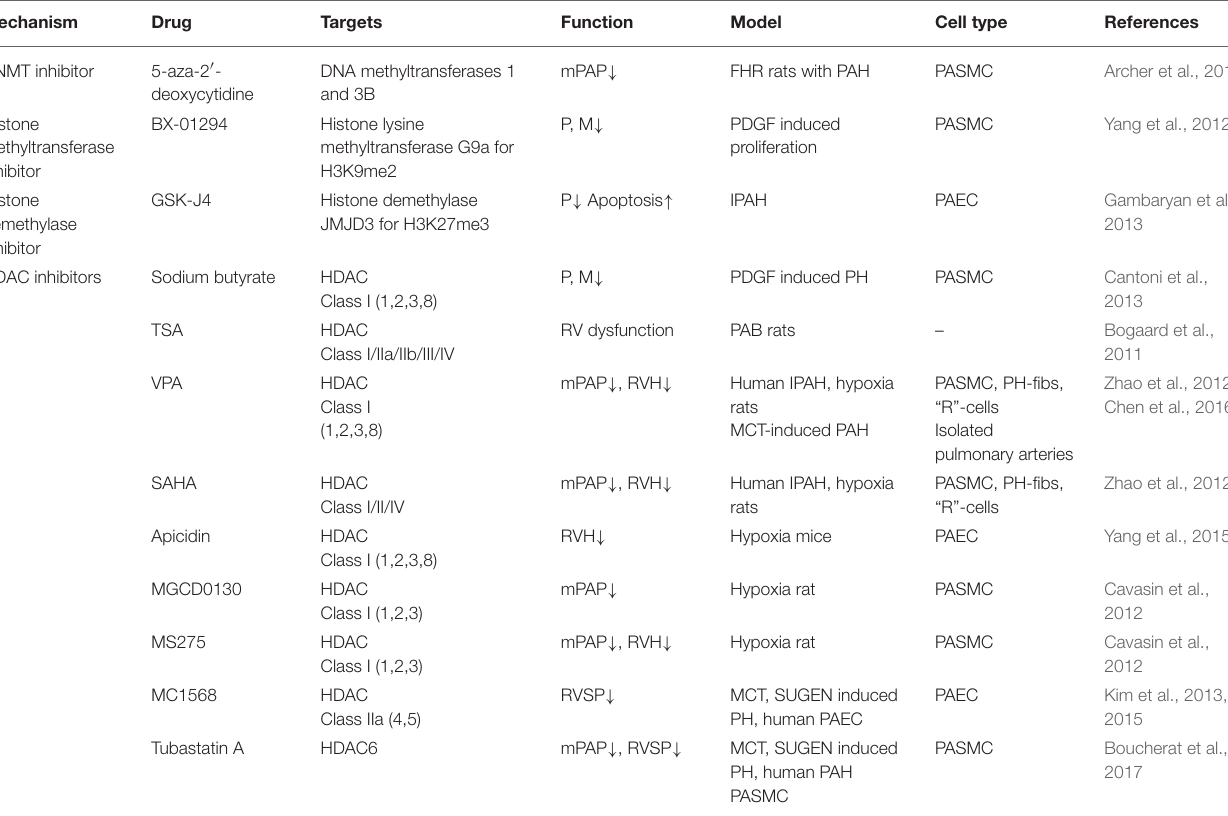
TABLE 2 | Current use of various epigenetic modifiers in PAH.